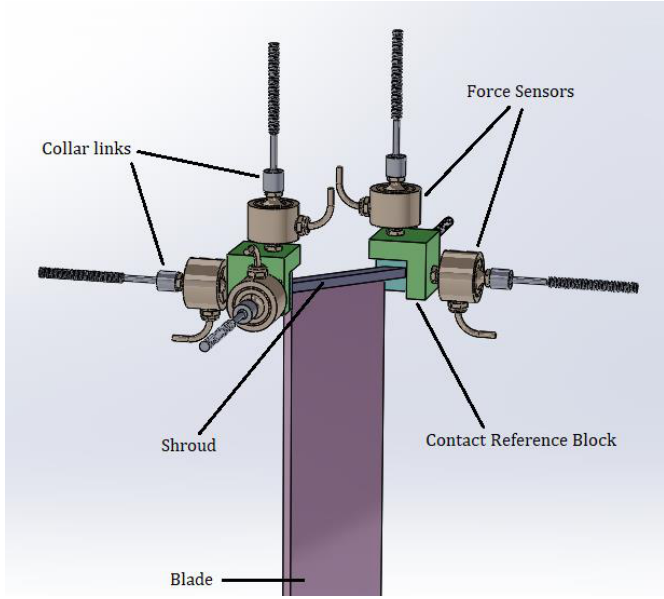
Figure 2. Blade shrouds in contact with force measurement system in the proposed test rig.